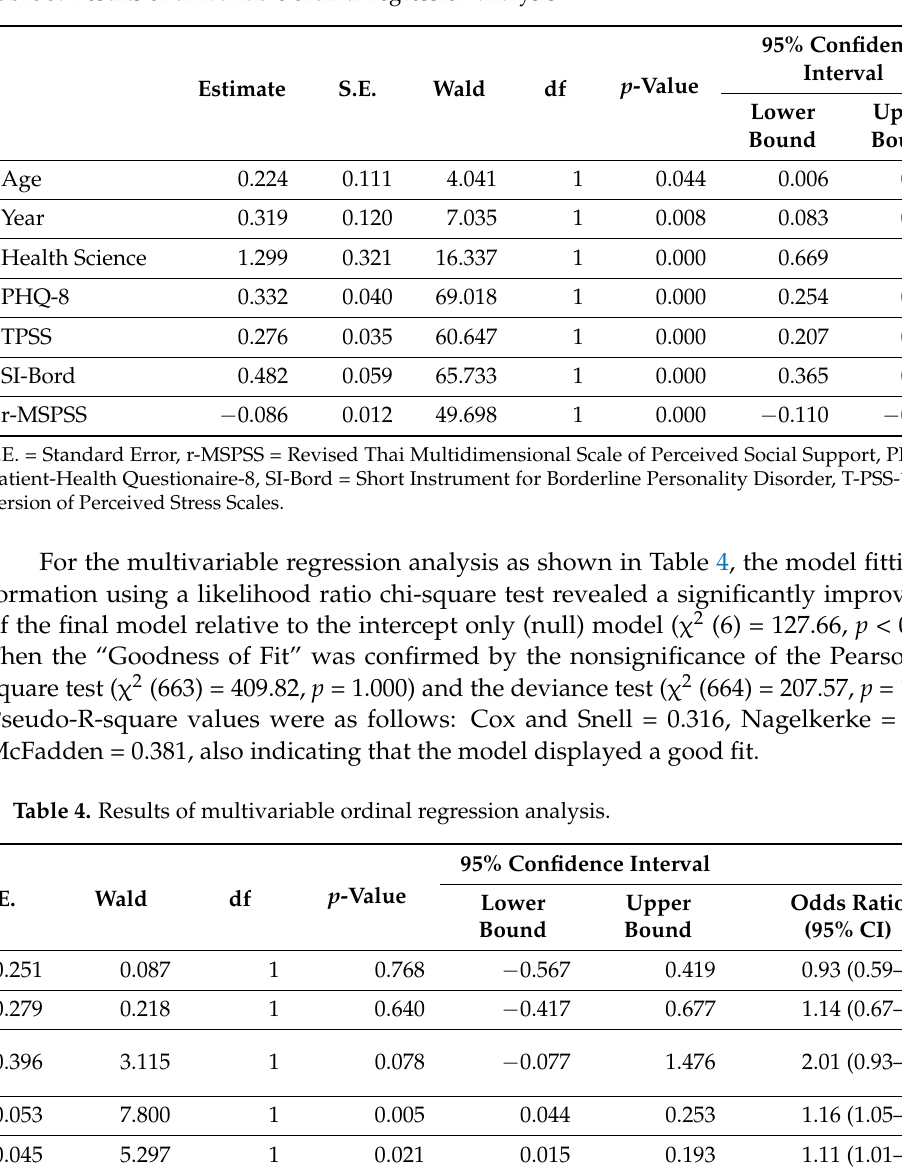
Table 3. Results of univariable ordinal regression analysis.